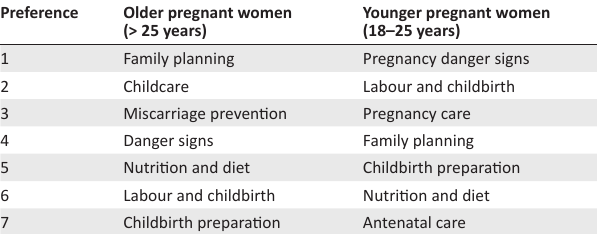
TABLE 7: Pregnant women information needs.